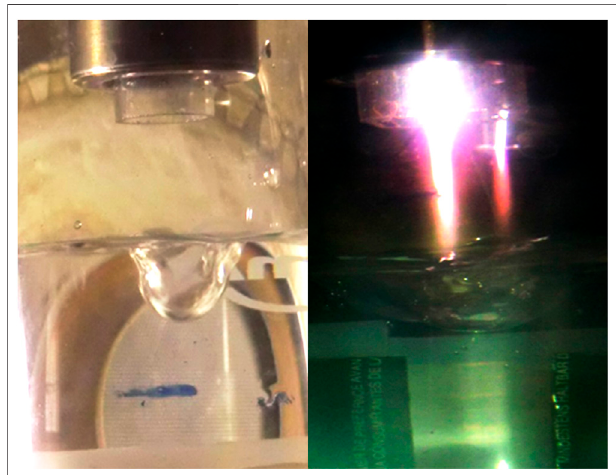
FIGURE 2 | View of a pit on the water surface formed with the gas dynamicpressure,beforemicrowavepowerswitchon(pictureonleft).Viewof amicrowaveplasmajetafterplasmaignition(onright).Abrightlyglowingtorch rod is surrounded by a less bright halo of photoionization of nitrogen, steam and air. Behind, it is seen the torch re fl ection in the wall of the